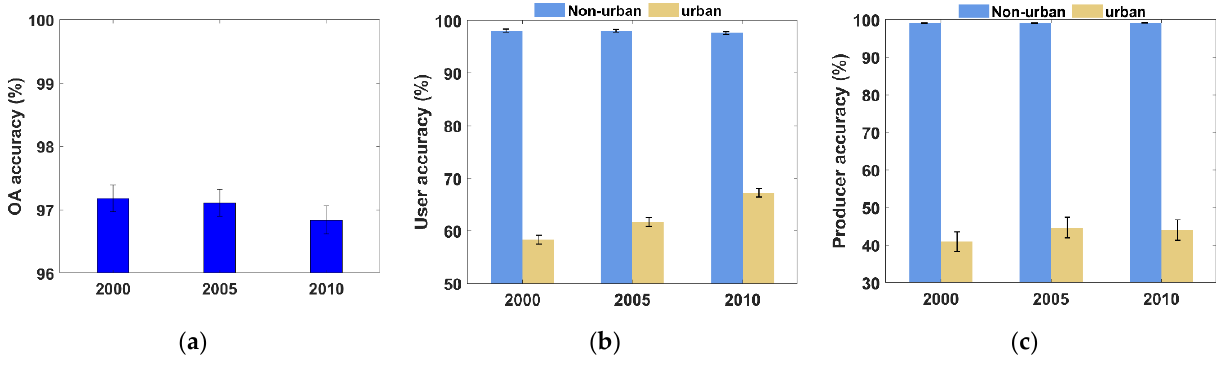
Figure 10. Accuracy estimation for the multi-temporal global urban land-cover product in single dates. ( a ) OA, ( b ) UA, and ( c ) PA. dates. ( a ) OA, ( b ) UA, and ( c )